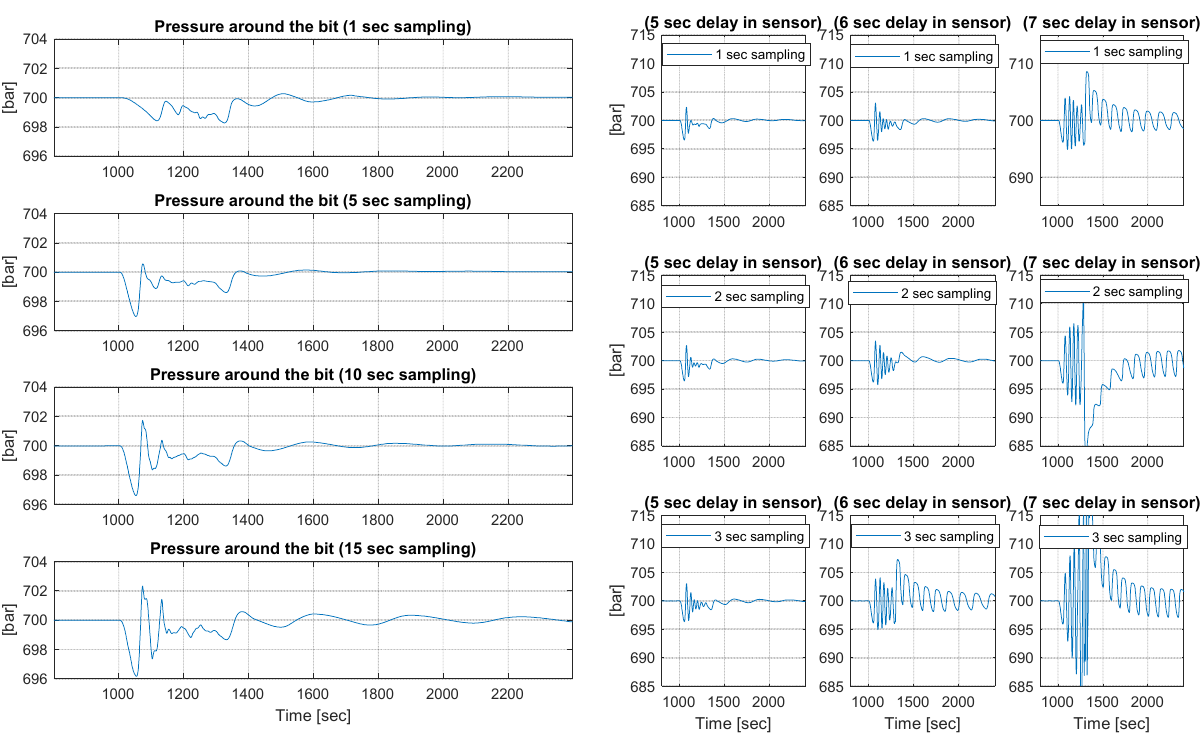
Figure 8: Pressure response due to different sampling times.